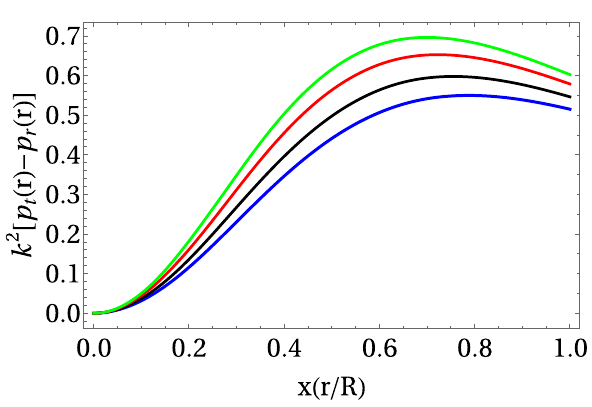
Fig. 12 k 2 [ p t ( r ) − p r ( r ) ] for Model II for compact factors: 0.38 (blue line), 0.39 (black line), 0.40 (red line) and 0.407 (green line)